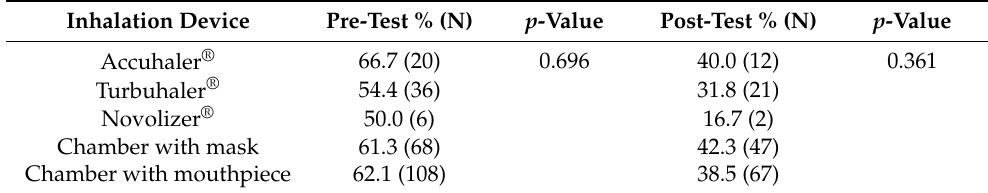
Table 2. Failure rate in the inhalation technique before and after the education intervention, based on the various inhalation devices in the pediatric population with respiratory pathologies.